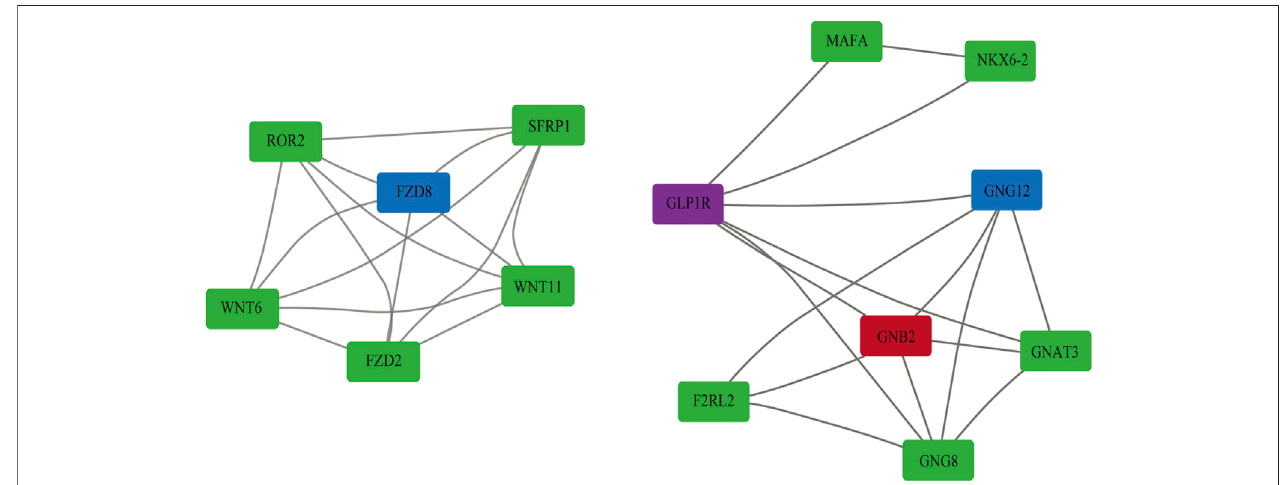
FIGURE 6 | A subnetwork of the key drivers that connected the up and down regulated genes. Purple indicates upregulated genes, red indicates key drivers of upregulated genes, green indicates downregulated genes, and blue indicates key drivers of downregulated